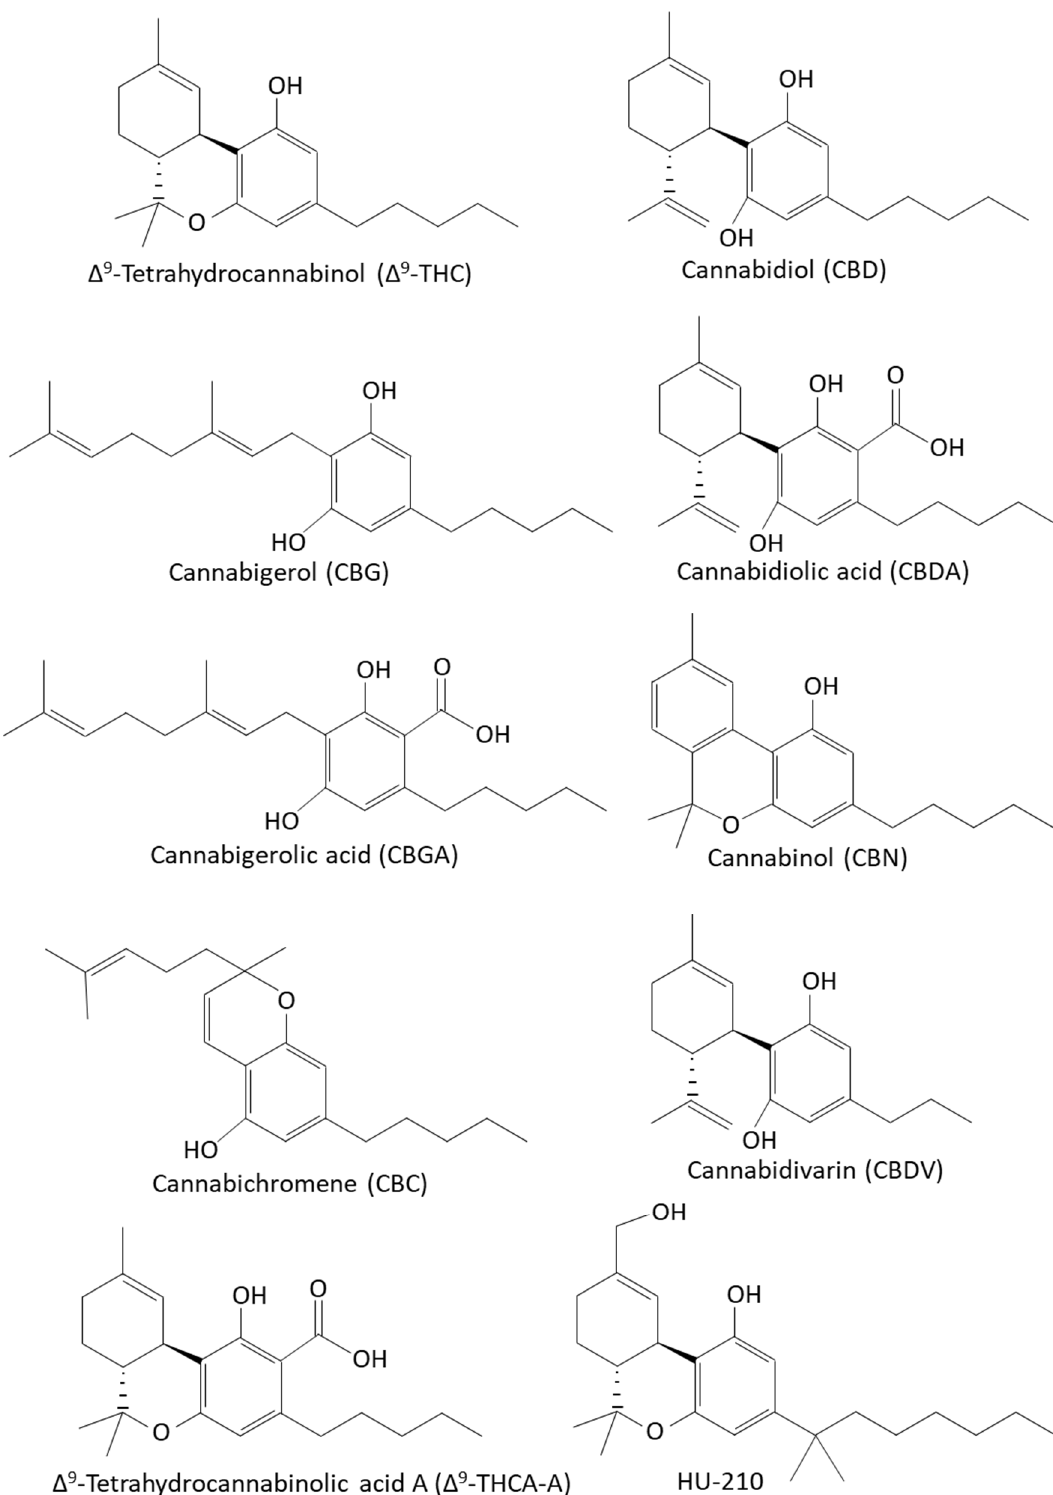
Figure 1. The chemical structures of some phytocannabinoids and the synthetic cannabinoid HU- 210.